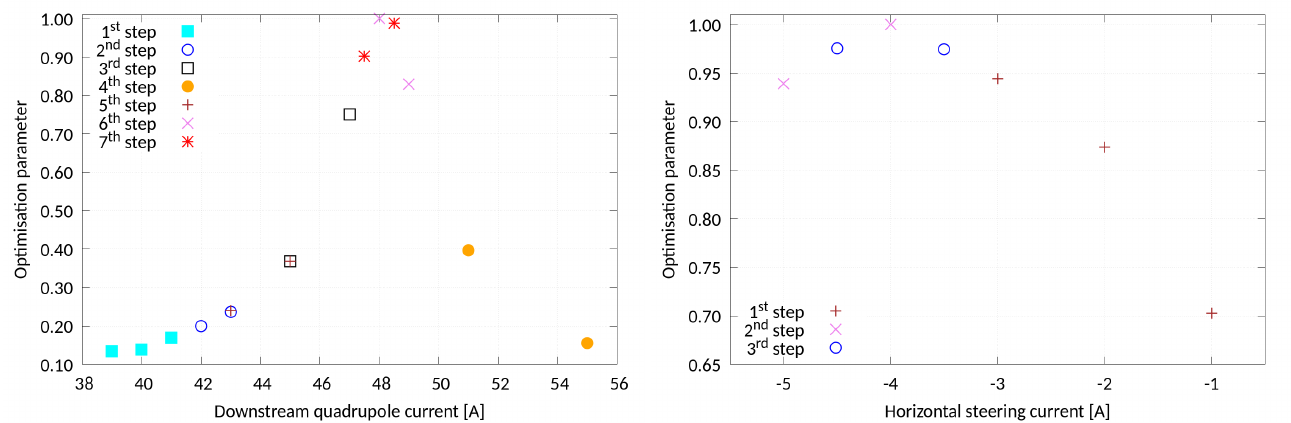
Figure 4. Examples of the optimization process for one quadrupole ( left ) and one steering magnet ( right ). The succession of the steps with the corresponding magnet current variations is